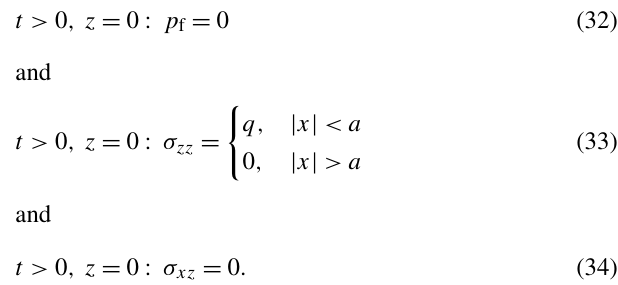
Figure 3. The solution of the consolidation problem in plane strain by RHEA is shown in a sample 10m in width and height. (a) Con- tour plot of the solution at time 1 × 10 − 2 s. (b) Comparison of the semi-analytical solution (continuous line) and the RHEA solution (dotted line). The differences in pore pressure between both ap- proaches is due to the assumption of an infinite domain in the an- alytical solution which is not feasible to replicate the latter with